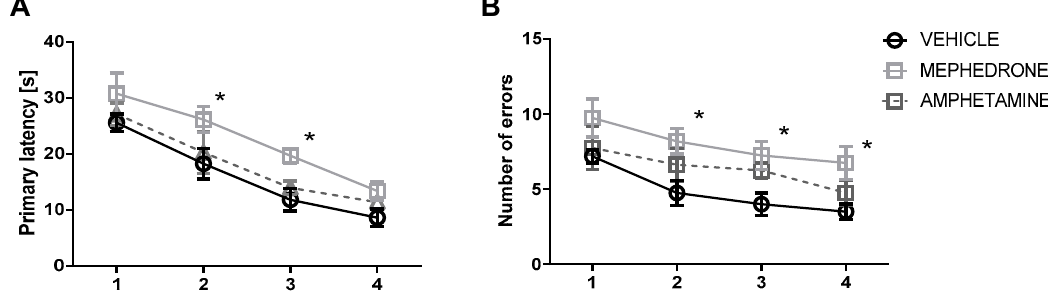
Figure 2. Effect of repeated mephedrone or amphetamine administration on ( A ) primary latency and ( B ) number of errors committed during 4 days of acquisition training of the Barnes maze task (PND 67-70). Data are expressed as the mean ± SEM. n = 8 rats/group. * p < 0.05 vs. vehicle (0.9% NaCl).